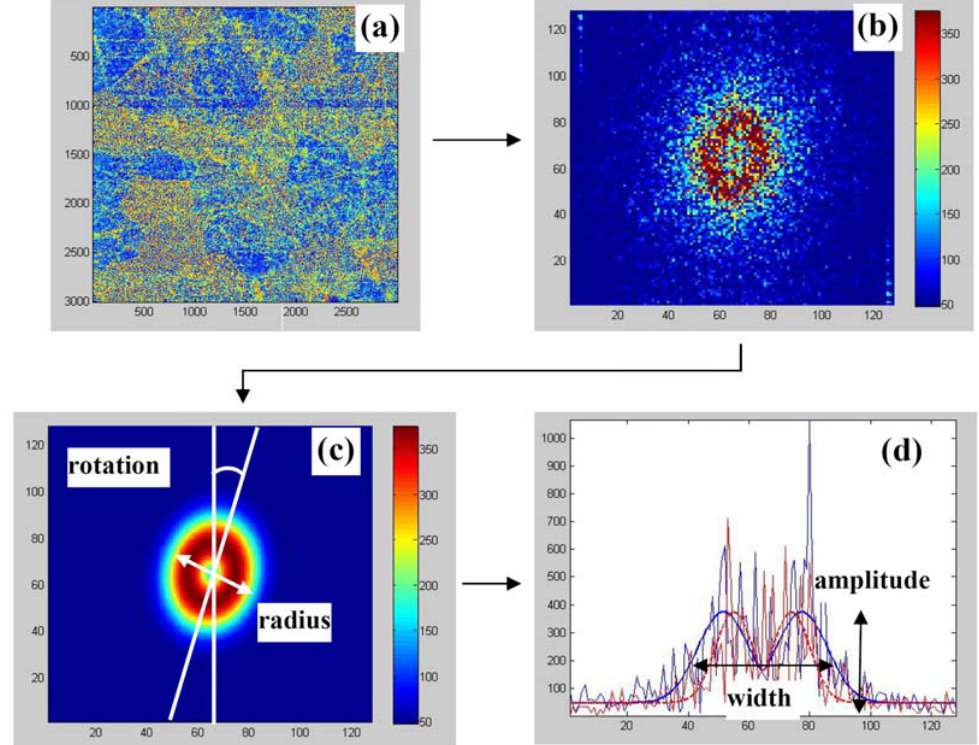
Figure 4. The interface (step-by-step) of a program for plotting maps images after 2D-FFT procedure. ( a ) piezoresponse image of PLZT ceramics; ( b ) Fast Fourier Transform (FFT); ( c ) FFT after smoothing; ( d ) cross-section from ( c